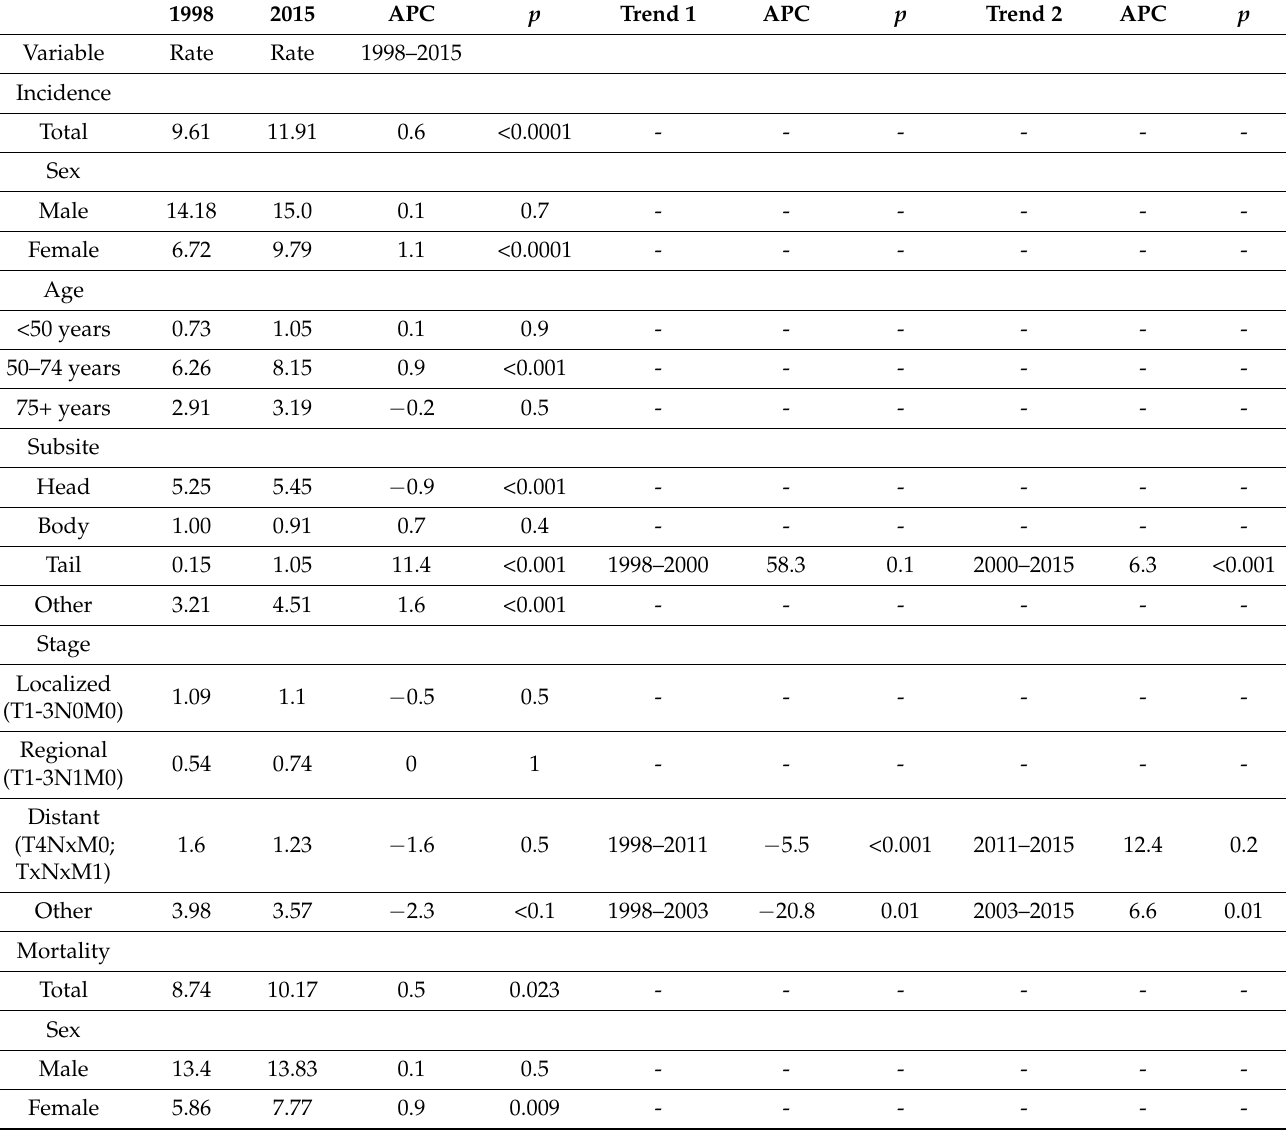
Table 1. Pancreatic cancer incidence and mortality joinpoint analysis in Lithuania from